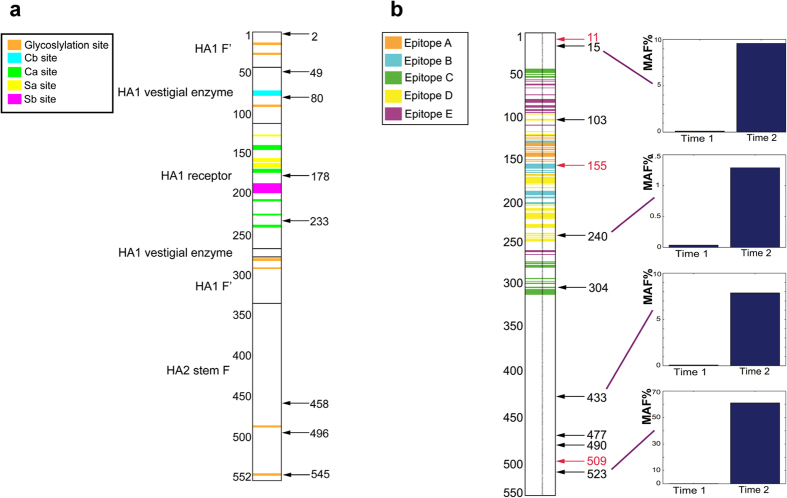
Domain map of the HA gene with location of coding mutations.(a) The coding region of the H1N1 HA gene is shown as a vertical bar with colored protein domains as noted in the legend. Amino acid number is listed on the left side. All of the coding mutations are shown as black arrows. Coding mutations were aligned to previously described antigenic and glycosylation sites (20602265, 20339031)1314. S545F was found in a previously identified glycosylation site. (b) The overall coding regions of the H3N2 HA gene is shown as a vertical bar with colored protein domains as per the legend15. Amino acid number is listed on the left side. All of the coding mutations [black arrows] and deletions [red arrows] were aligned to previously described H3 epitopes15. On the left of the domain and mutation map, the expanded coding mutations from Patient 328011 are shown on a linear MAF histogram plot. Of the eight mutations, P103S and G240R occurred in Epitope D and A304T occurred in Epitope C. One of the three deletions (C155) occurred in Epitope B.